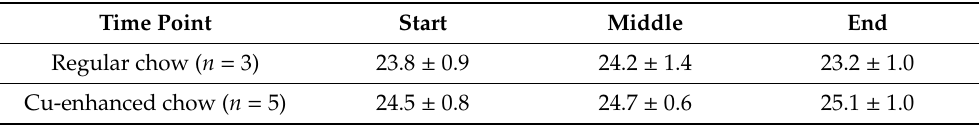
Table 1. Average Body Weight (g) Changes of the APP / PS1 Transgenic Mice during Cu Treatment Period